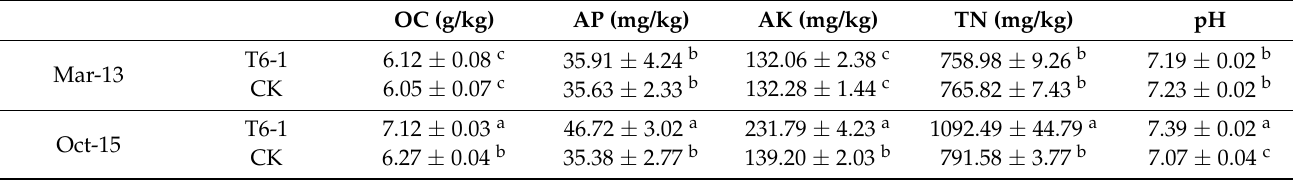
Table 2. Edaphic properties of soils in March 2018 and October